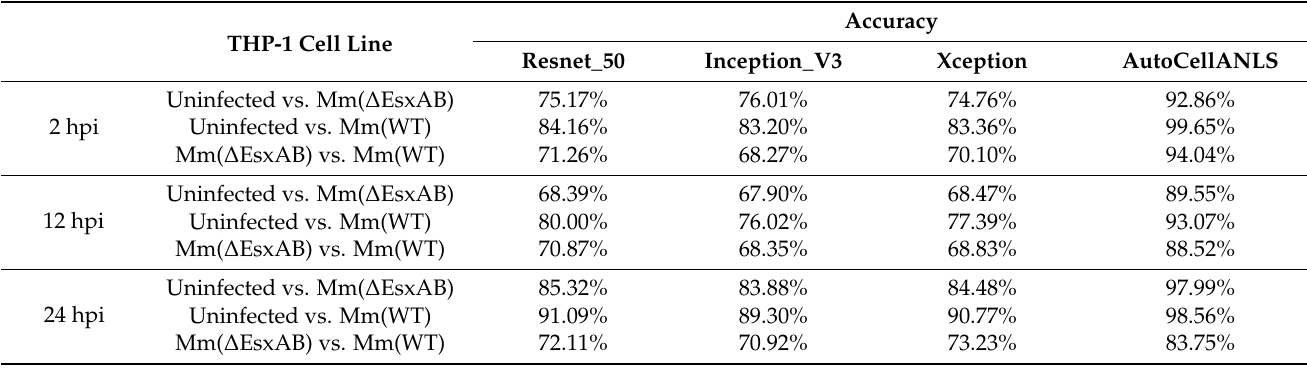
Table 5. The Comparison of THP-1 cell classification results for different